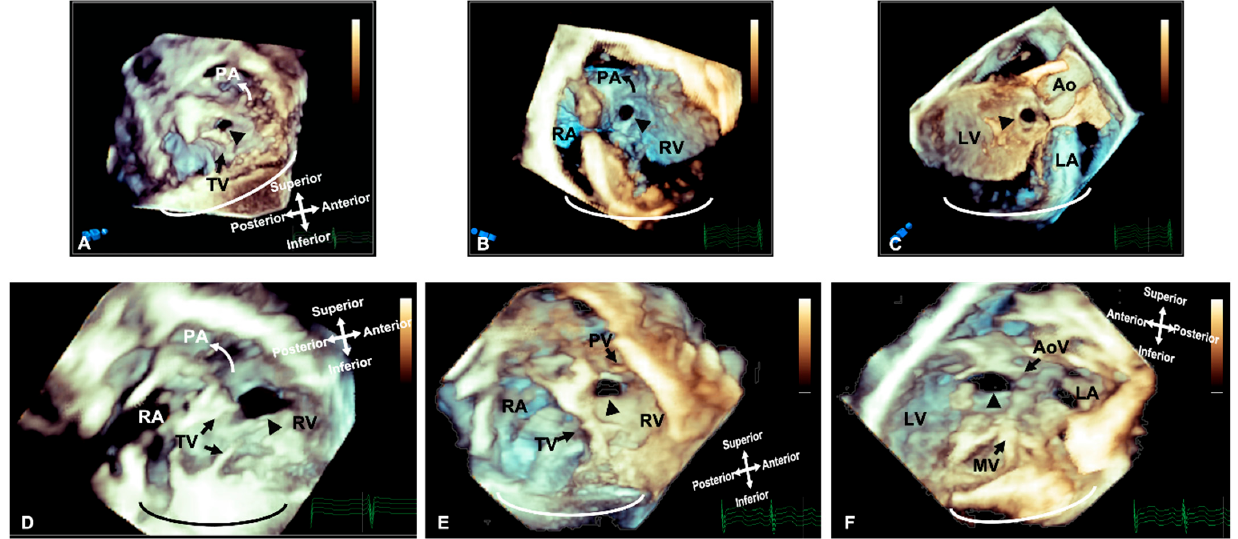
Figure 1. Three-dimensional rendered imaging demonstrating the appearance of VSDs of various morphologies. ( A ) Demonstrates a perimembranous VSD (arrowhead), as seen from the right ventricular view—here, we can see the area of proximity between the defect and the TV, which allows fibrous continuity between the AoV and the TV. An outlet muscular VSD (arrowhead) seen from the right ventricle and ( B , C ) left ventricle—the tissue surrounding the defect and the distance from the AoV makes it suitable for consideration of device closure. ( D ) A view from the right ventricle showing a large muscular VSD (arrowhead) positioned more anteriorly towards the pulmonary artery. A doubly committed VSD, as seen from the right ventricle ( E ) and left ventricle ( F ), demonstrating the proximity to the outlet valves, which allow fibrous continuity of the PV and AoV. All images are shown in anatomic orientation. Ao: Aorta; AoV: Aortic valve; LV: Left ventricle; MV: Mitral valve; PA: Pulmonary valve; PV: Pulmonary valve; RA: Right atrium; RV: Right ventricle and TV: Tricuspid valve.